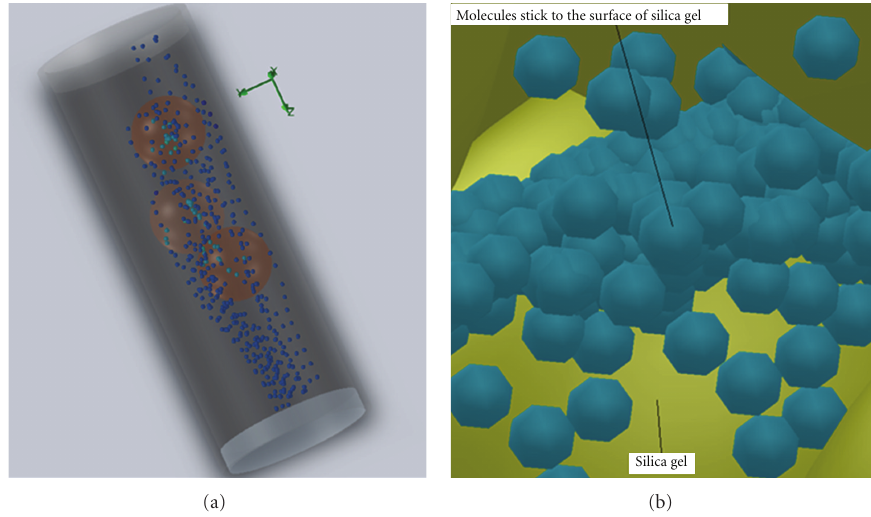
Figure 14: The adsorption starting to take place with the formation of multilayer of adsorbate on adsorbent.